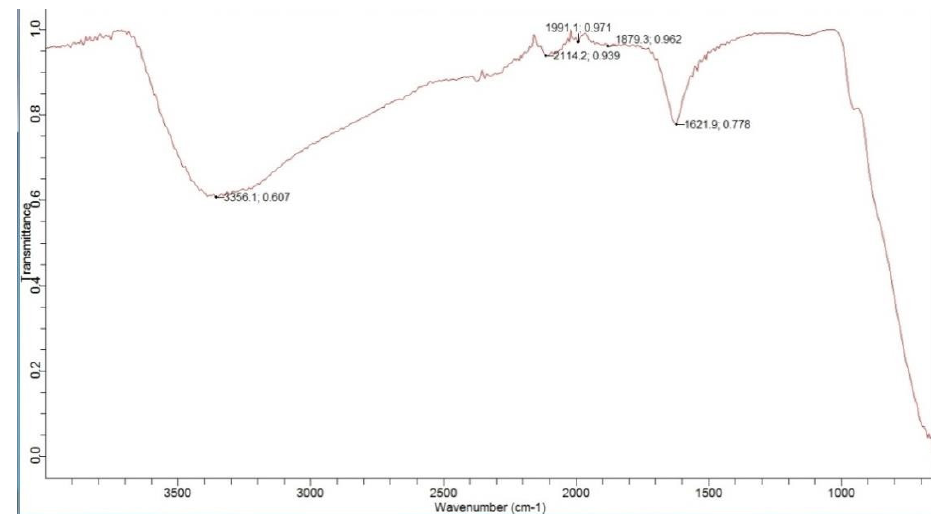
Figure 5. FTIR spectrum of g-C 3 N 4 -NiWO 4.